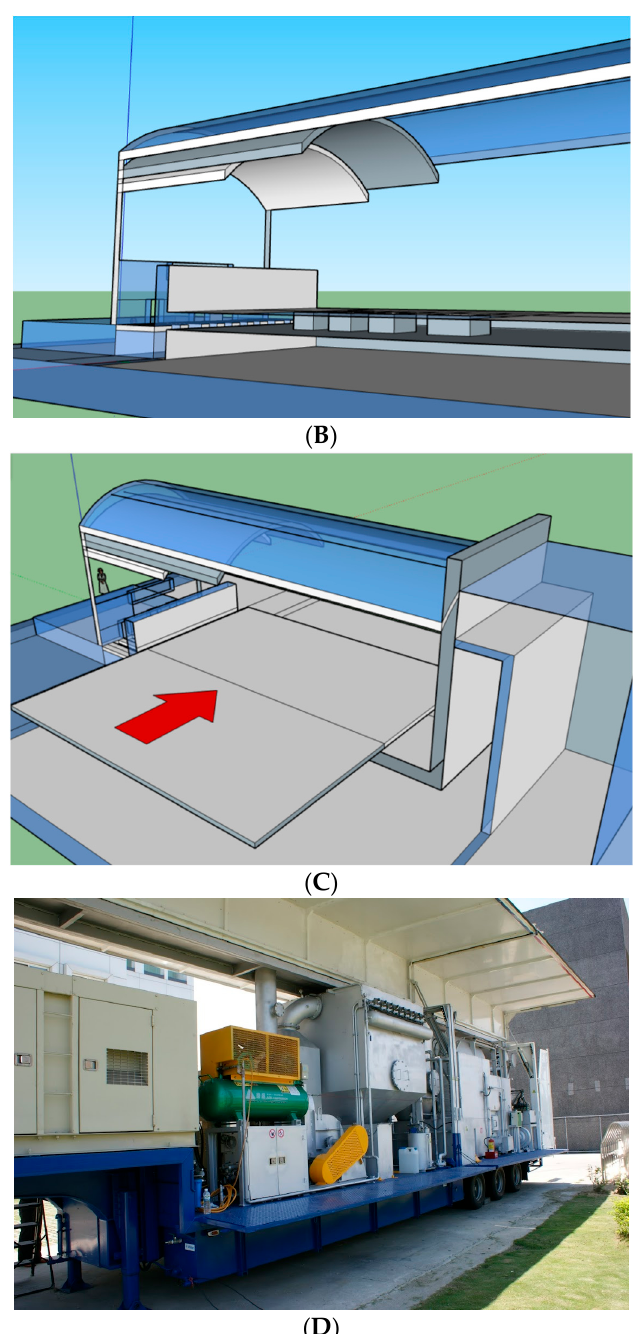
Figure 2. Kiln boat design (Tzu-Chieh Lee, 2021). ( A ) Kiln boat sketch. ( B ) Three layers of the kiln’s roof. ( C ) Lateral conveyor belt. ( D ) Hydrogen kiln on truck (Tzu-Chieh Lee, 2021, https://www.oxy-hydrogen.com/about/6, accessed on 11 February 2022) [29].